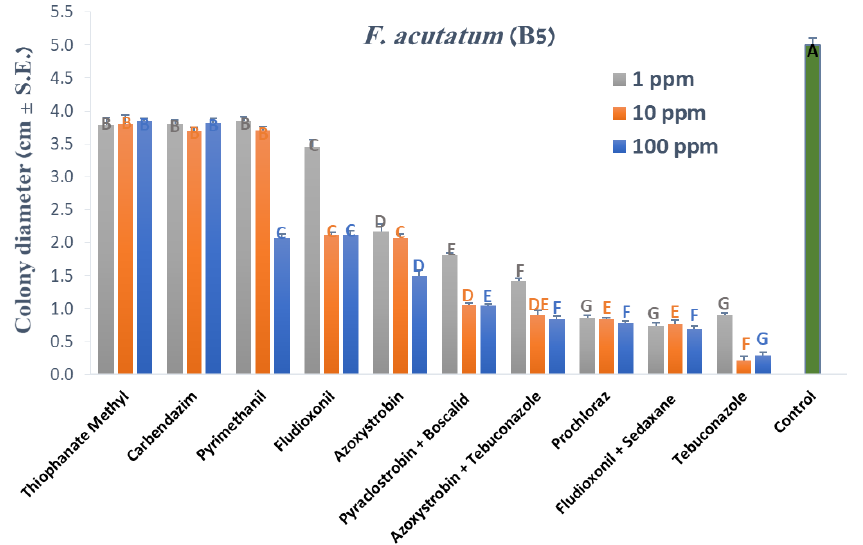
Figure 1. Effect of selected fungicides on the development of Fusarium acutatum (isolate B5) in culture media. The fungicides were tested at concentrations of 1, 10 and 100 PPM. The fungicides are described in Table 2. Culture agar discs from a five-day-old colony were grown on Petri dishes containing anti-fungal commercial preparations and incubated under dark conditions at 28 ± 1 ◦ C for four days. The control treatment is colonies that were grown under the same conditions without fungicide. The columns represent an average diameter of six replications, error lines represent standard error. Different letters above the columns represent a significant difference ( p < 0.05) in the one-way analysis of variances (ANOVA) test.